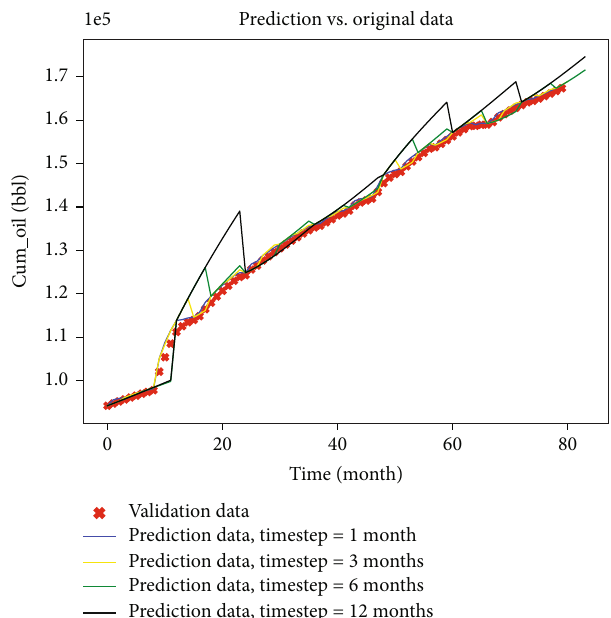
Figure 18: Comparisons between cumulative oil production data with predicted data as the function of timesteps. The scale of the y -axis is in an order of 10 5